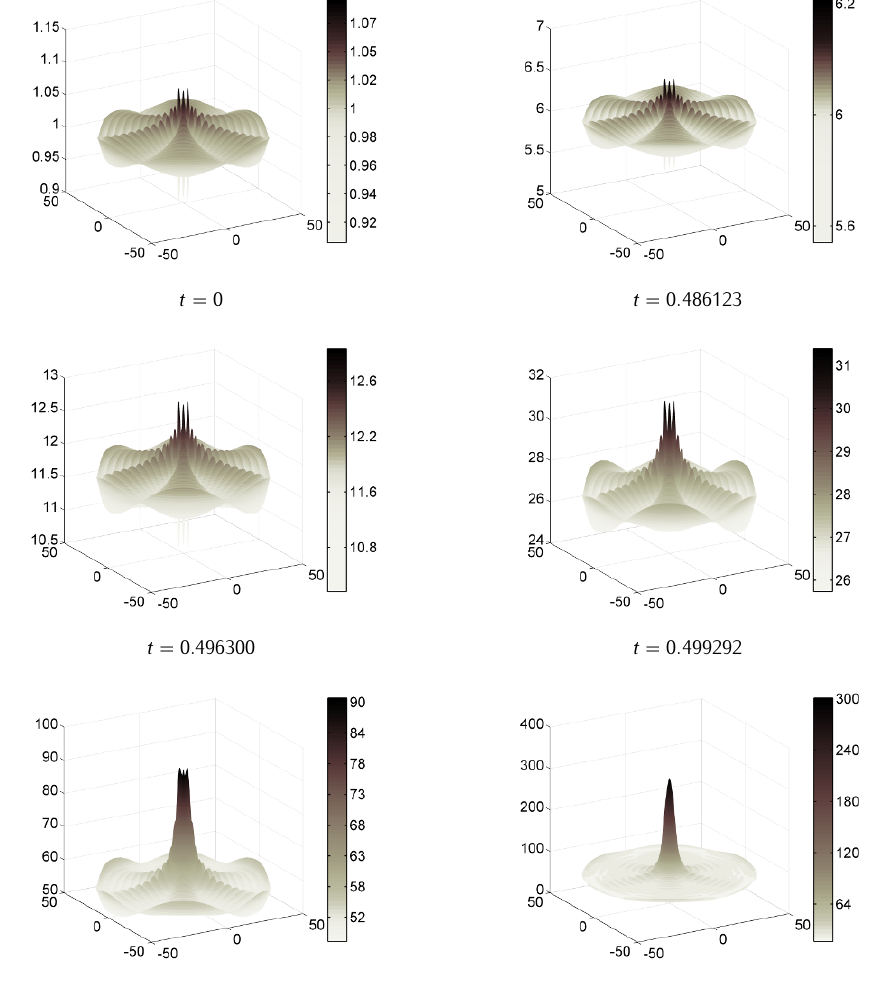
Figure 7. Evolution in time of the self-similar solution u